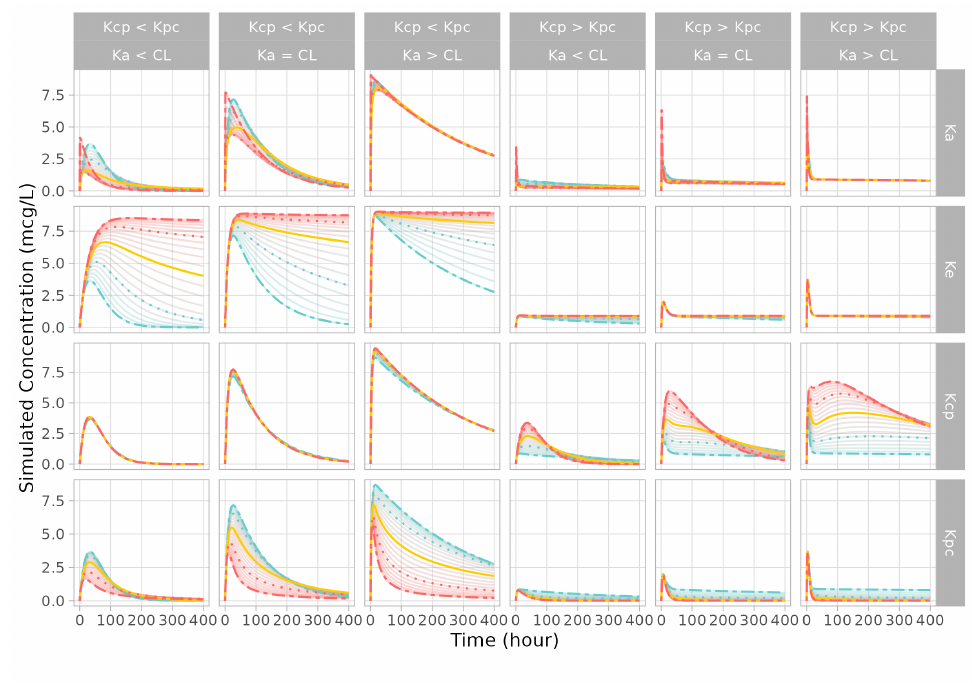
Figure 3. Simulated PK profiles of two-compartment model from parameter sets (upper labels) and fractionally modified rate (right labels). Changes in the fractal exponent are plotted from 0 (blue line) to 1 (red line) by 0.05. The exponent of 0.25/0.75 is shown as dashed orange lines, and 0.5 is plotted as solid orange line. The first three columns present the concentration profile when the central volume is greater than the peripheral volume, and the rest of the columns represent the profiles with the central volume being less than the peripheral